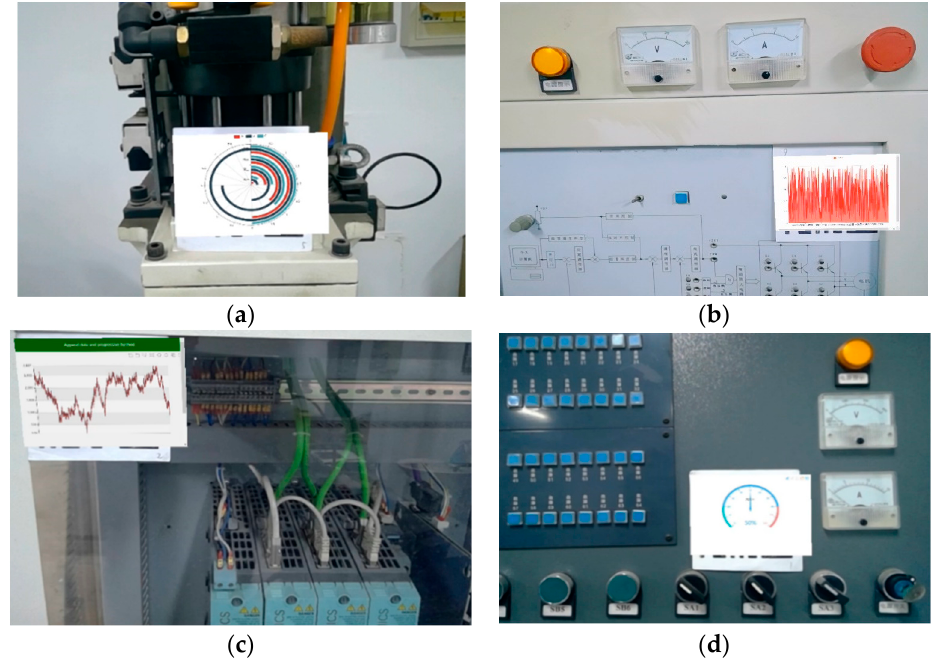
Figure 13. Industrial virtual instrument AR display: ( a ) display pie chart; ( b ) display bar chart; ( c ) display line graph; ( d ) display dashboard.